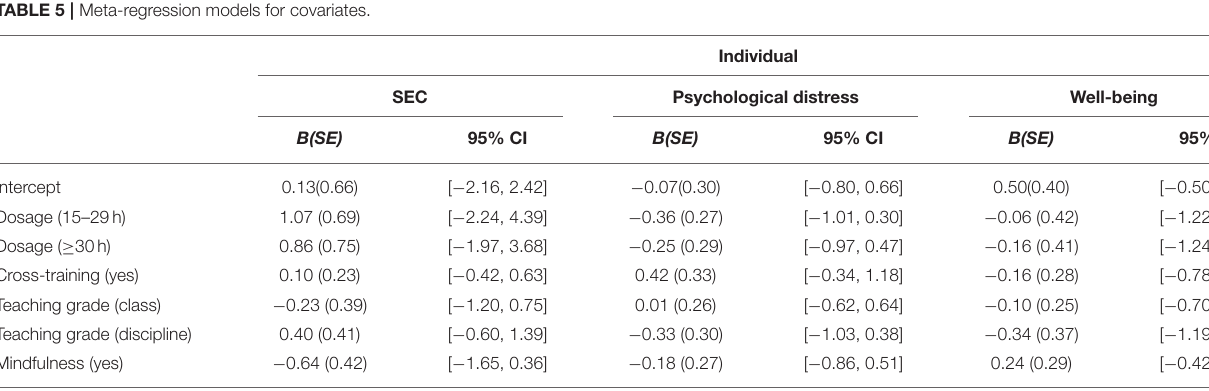
TABLE 5 | Meta-regression models for